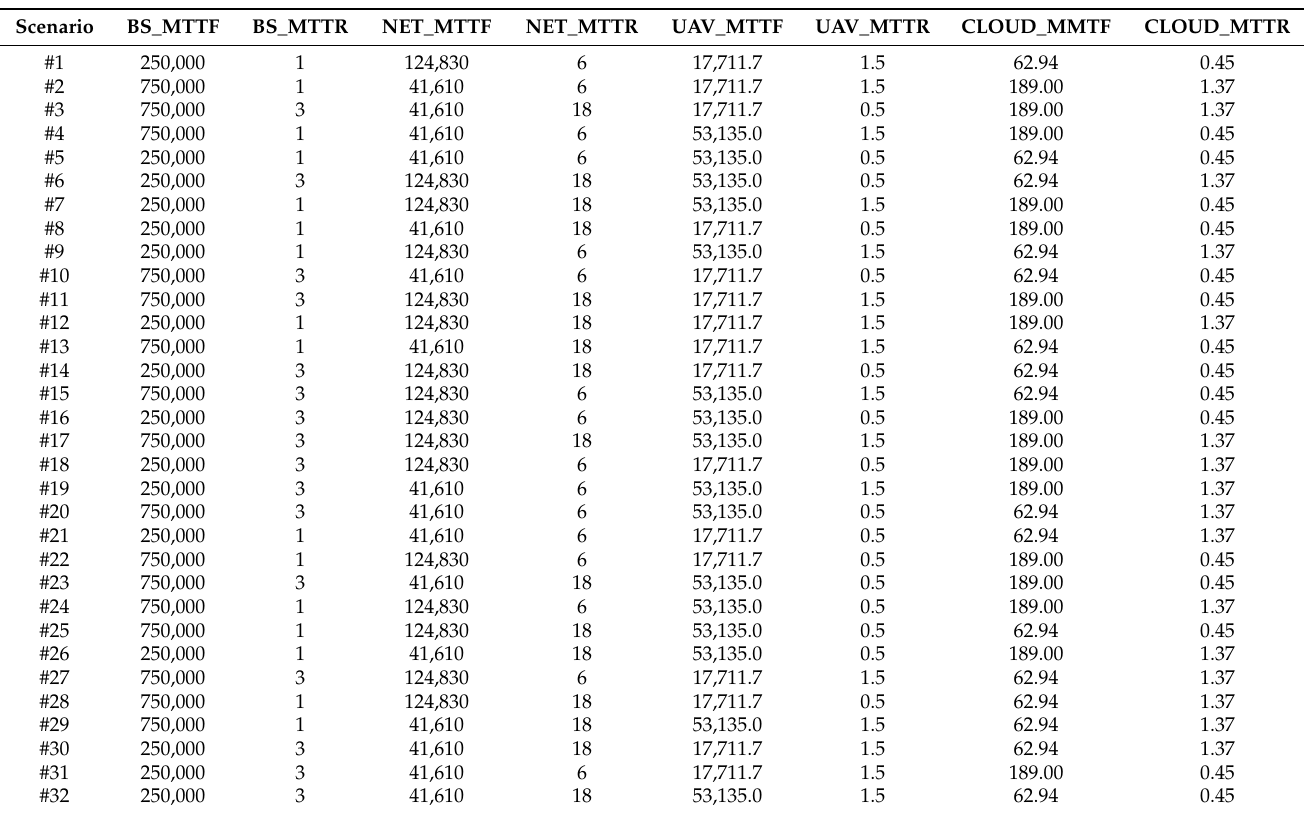
Table 3. Design of Experiments (all values are in hours).